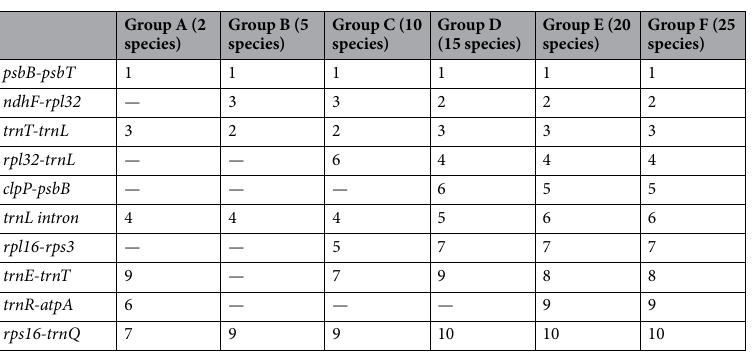
Table 2. SV rankings of the top-ten mutational hotspots in six groups. “—” Means this locus ranked outside of the top-ten mutational hotspots. Group A: D . primulinum , D . gratiosissimum . Group B: D . primulinum , D